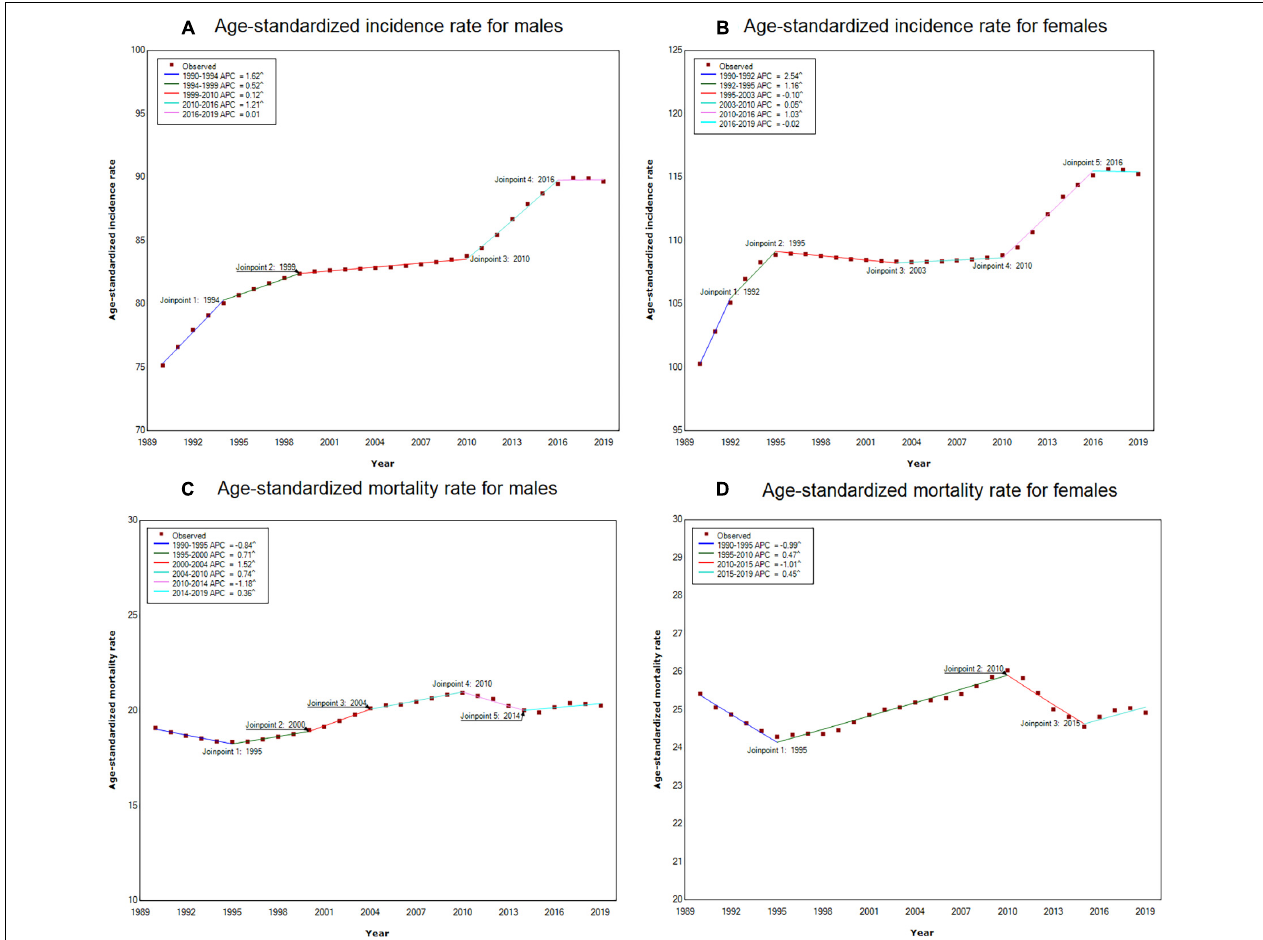
FIGURE 2 | Joinpoint regression analysis of the sex-specific age-standardized incidence and mortality rates for Alzheimer’s disease and other forms of dementia in China from 1990 to 2019. (A) Age-standardized incidence rate for males; (B) Age-standardized incidence rate for females; (C) Age-standardized mortality rate for males; (D) Age-standardized mortality rate for